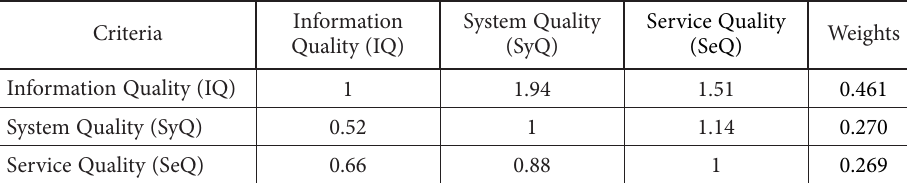
Table 3. Pair-comparison matrix and weights of